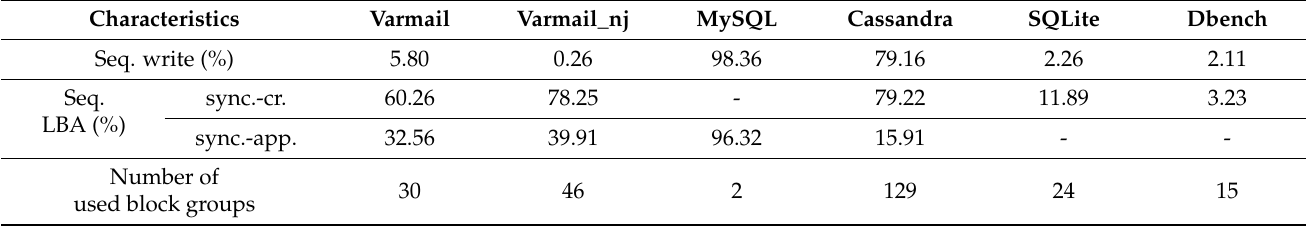
Table 5. Logical block addressing (LBA) characteristics of data write requests.